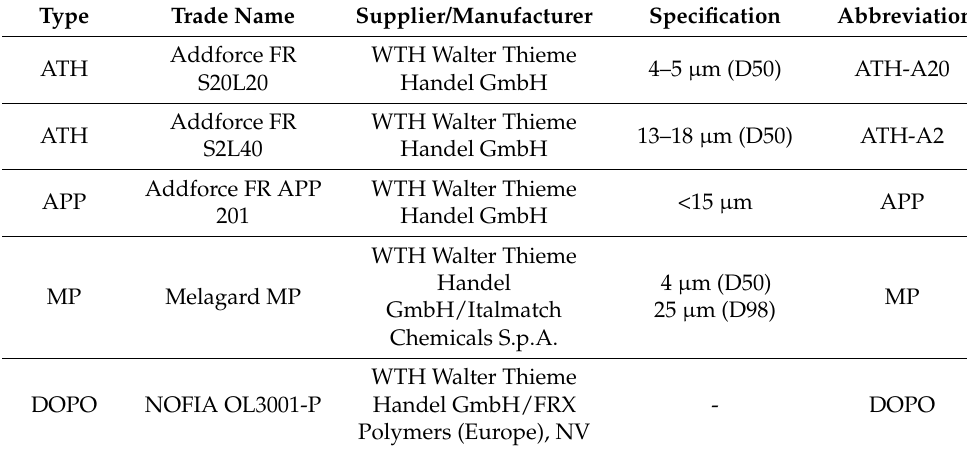
Table 1. Summary of flame retardants used in this study. Particle size derived from technical data sheets